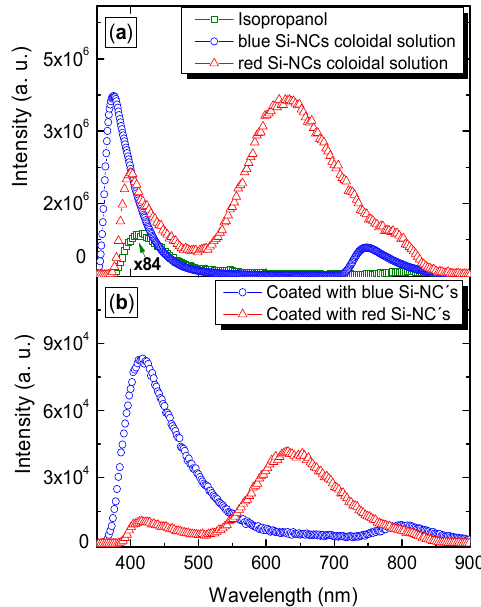
Figure 7. (Color Online) PL (Photoluminescence) spectra obtained at room temperature from colloidal solution ( a ); and from coated films with red and blue Si ‐ NCs without annealing ( b ).